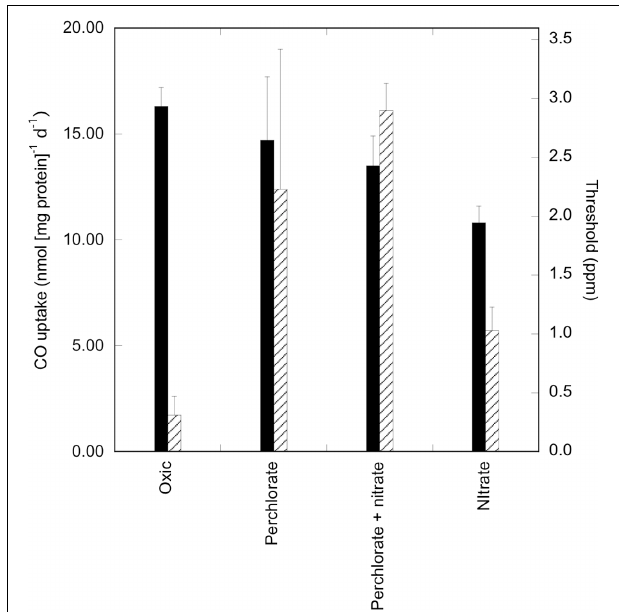
FIGURE 4 | Perchlorate-coupled CO uptake by Halobaculum sp. WSA2. CO uptake rates (nmol CO [mg protein] − 1 d − 1 ) and uptake thresholds (ppm) for isolate Halobaculum sp. WSA2 during aerobic and anaerobic incubations in 3.8 M NaCl with perchlorate, perchlorate + 0.25 mM nitrate, or with 25 mM nitrate; values are means of triplicate cell suspensions ± 1 standard